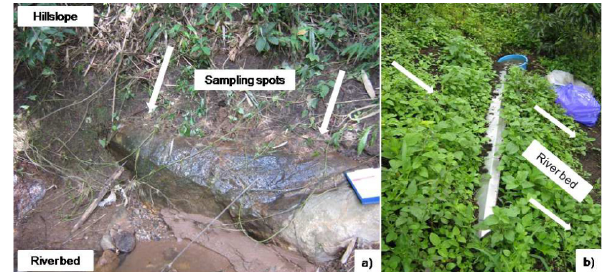
Fig. 2. Sampling of surface runoff (SUR) and (shallow) subsurface flow (SUB) at the study site (black square, Fig. 1b). (a) depicts the seep, which is defined as subsurface flow, (b) one of the steel gutters used to measure surface runoff along the